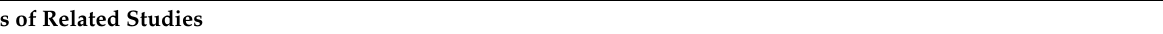
Table A1. Improvement summary of problems and challenges in security warnings.